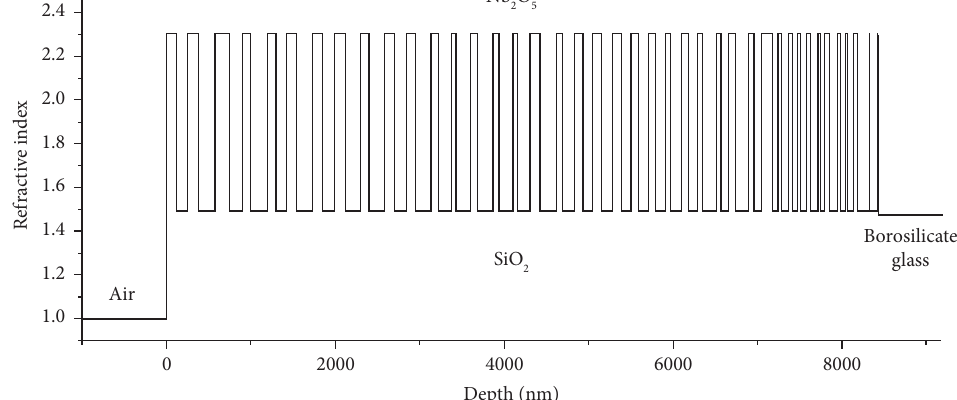
Figure 3: Change in the refractive index along the depth of the bandpass flter with nonquarter-wave design, showing the layer design structure, i.e., the thicknesses of Nb 2 O 5 and SiO 2 along the depth of the flter [22].